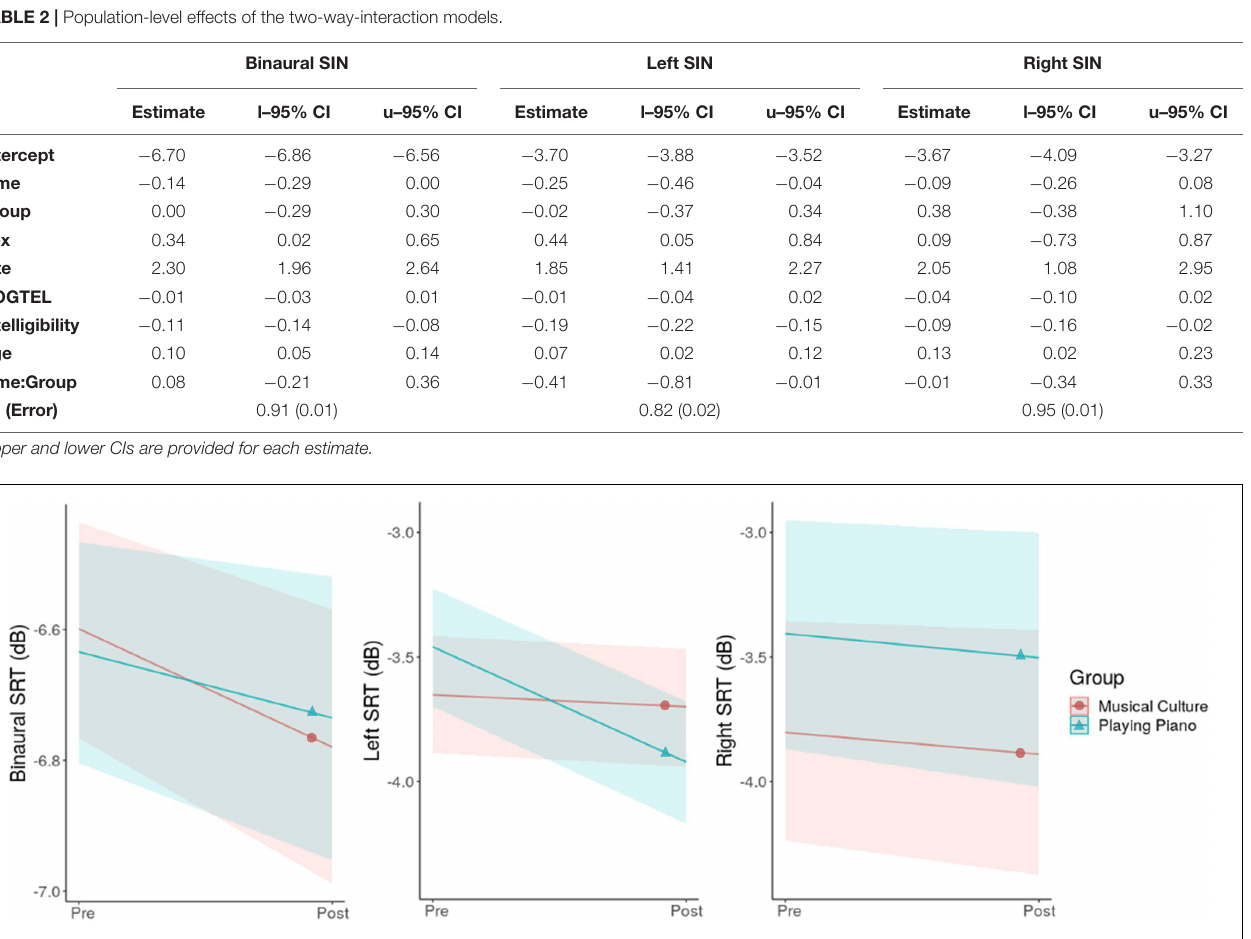
FIGURE 1 | Time-by-Group interaction plots for binaural, left and right SRT. The solid lines represent the estimated averages and the shaded areas their CIs.